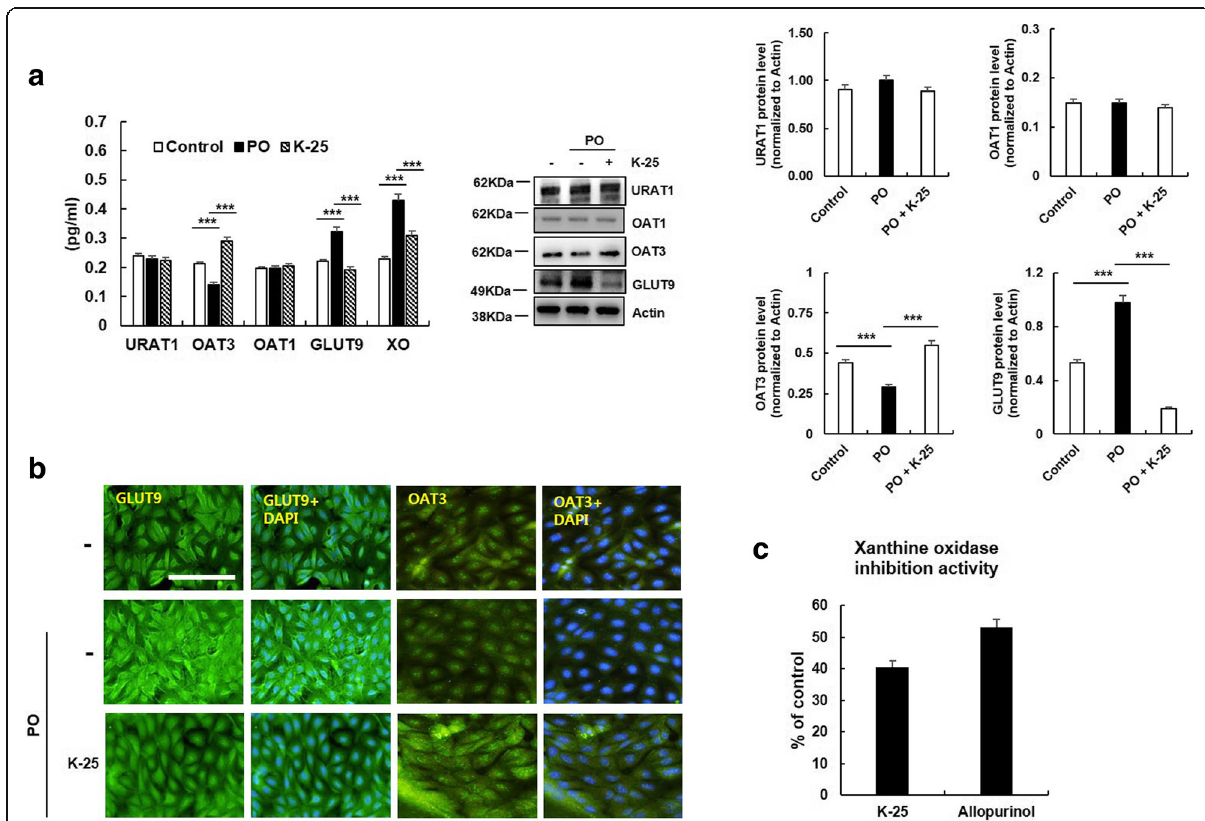
Fig. 4 Inhibition of PO-induced hyperuricemia by K-25. LLC-PK1 cells were stimulated with PO (0.25 mM) with or without pretreatment with K-25 (0.5 mg/mL). a After 24 h of incubation, OAT1, OAT3, URAT1, GLUT9, and XO were measured using an immunoblot assay. b LLC-PK1 cells were incubated with K-25 for 24 h, and the intracellular levels of OAT3 and GLUT9 transporters were analyzed using immunofluorescence analysis. Scale bar = 50 μ m. c Effect of K-25 on XO inhibition activity. Values are represented as means ± SEM, * p < 0.05, versus the allopurinol group. The statistical significance (* p < 0.05, ** p < 0.01, *** p < 0.001) was determined using ANOVA with Bonferroni